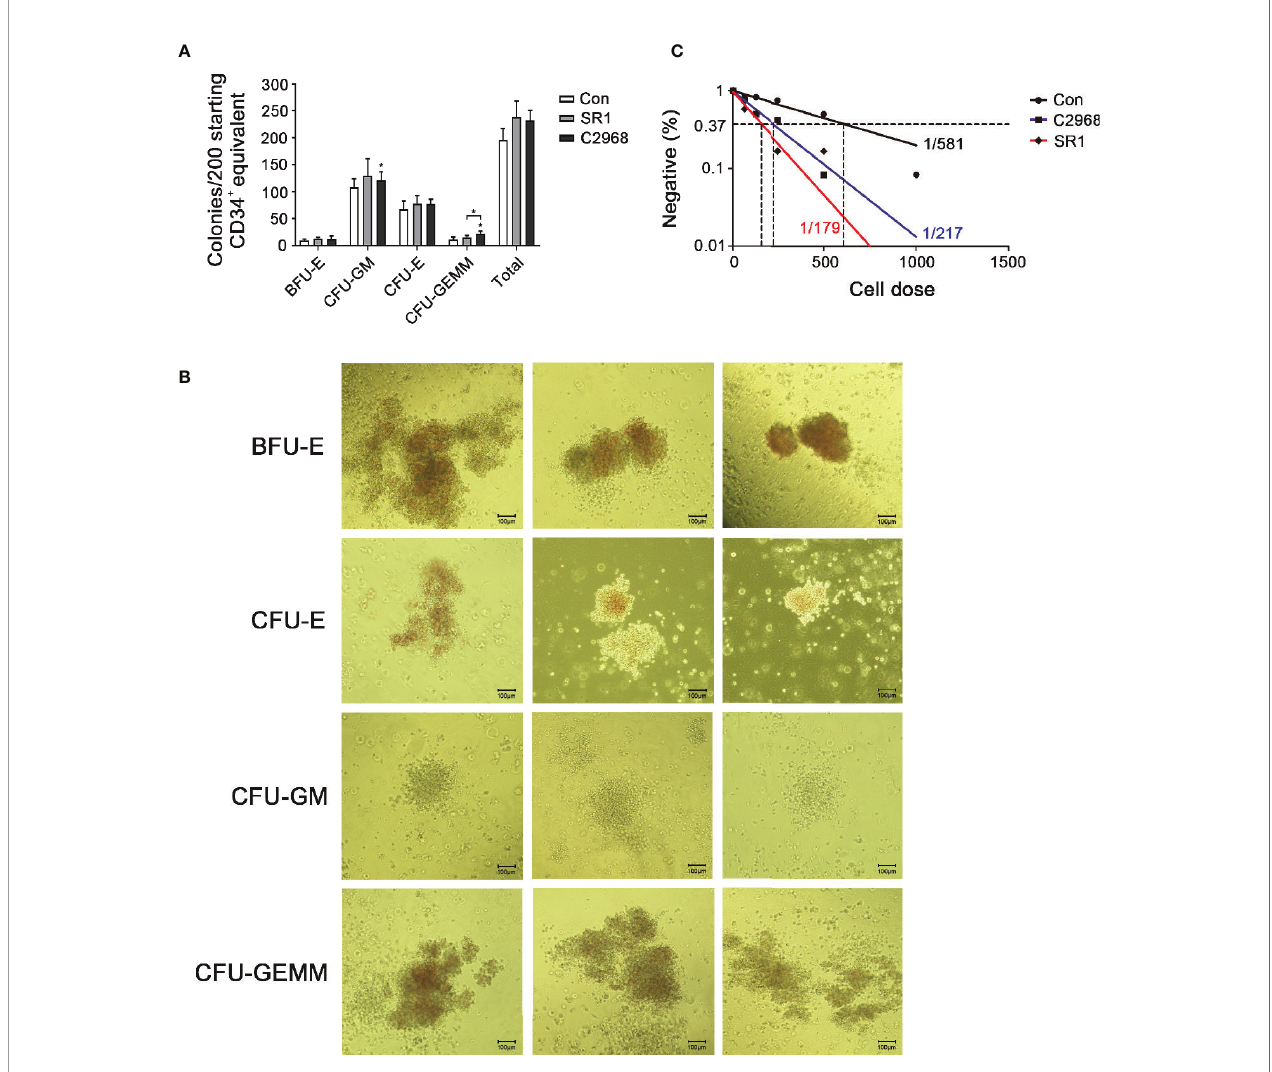
FIGURE 2 | Chrysin-treated CD34 + cells sustained in vitro multiple-differentiation potential and long-term hematopoietic capacity in culture. (A) Colonies derived from multipotent progenitor cells (BFU-E, burst-forming unit-erythroid; CFU-GM, colony-forming unit-granulocyte/macrophage; CFU-E, colony-forming unit- erythrocyte; CFU-GEMMs, colony-forming unit-granulocyte/erythrocyte/macrophage/megakaryocyte) after 14 days in H4434 methylcellulose culture (n = 4). (B) Representative morphological images of CFU colonies described in (A) . (C) Frequency of long-term repopulating cells within Con (DMSO 0.01%), SR1 (1 µM), or C2968 (2.5 µM) cultures measured by LDA. Positive well was de fi ned as having more than one cobblestone-like primitive hematopoietic area. All data represent the means ± SD. Compared with control unless speci fi ed, *p < 0.05 by two-tailed unpaired